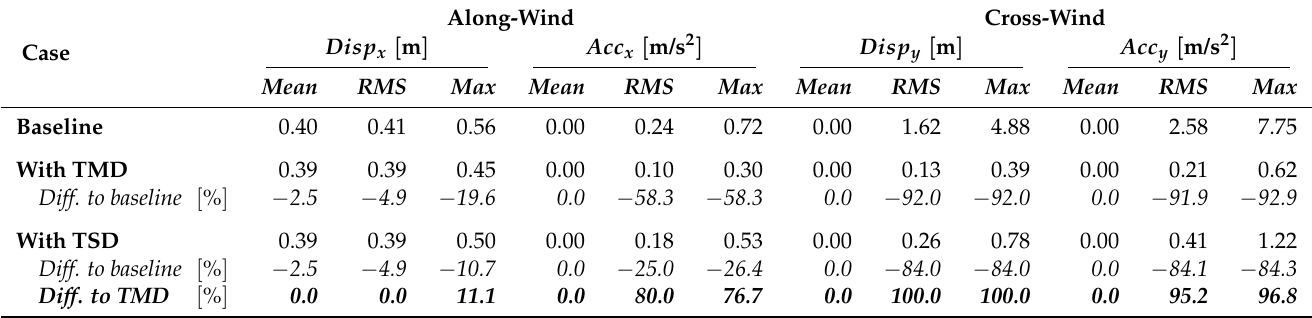
Table 4. Statistics of the kinematics of the top point in smooth